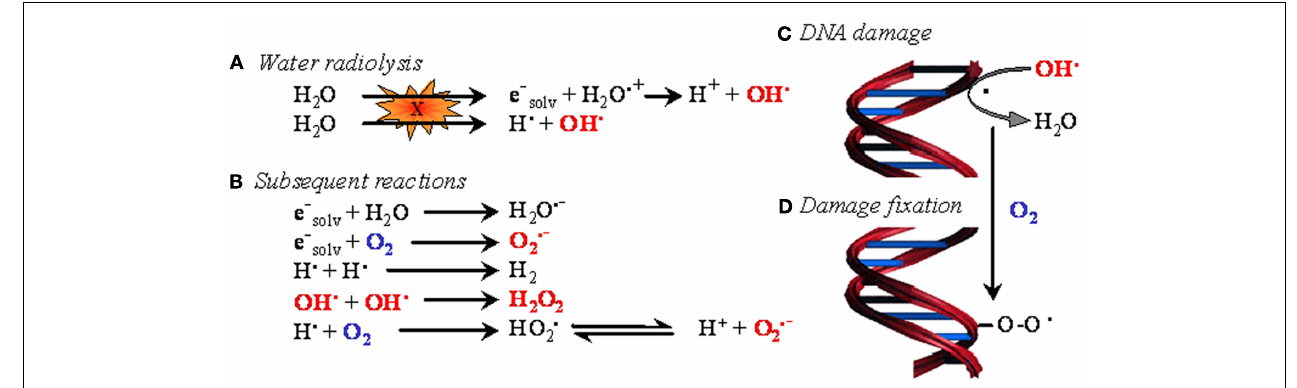
radicals and, to a lesser extent, other less energetic species attack DNA (C) .The resulting formation of a DNA radical is readily reversible. However, in the presence of oxygen, DNA damage can be stabilized through oxidation of DNA radicals, eventually leading to the formation of DNA peroxides (D) . In oncology, oxygen-dependent DNA damage fixation is known as the “oxygen enhancing effect” of